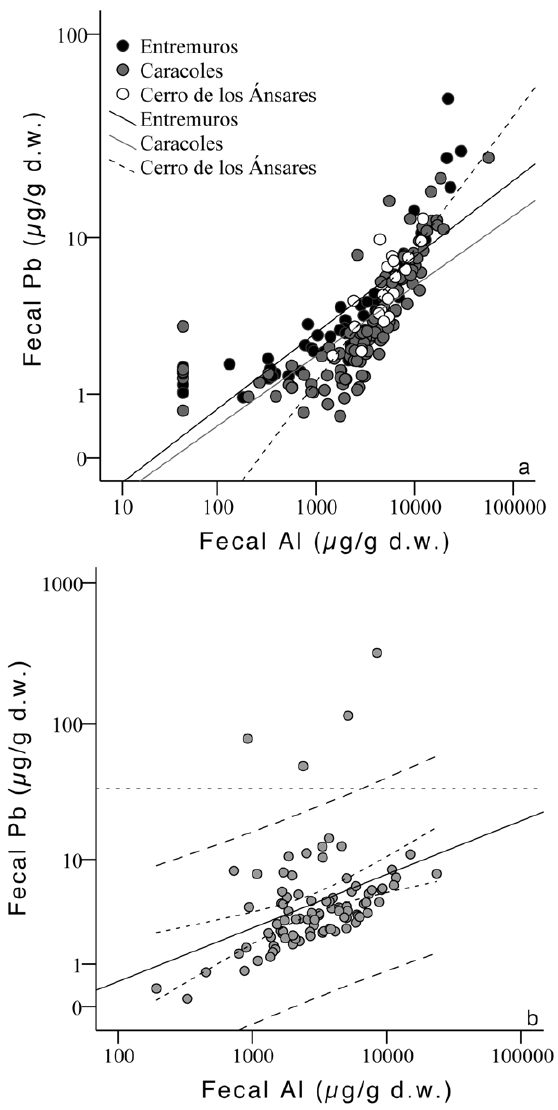
Figure 4. Relationship between Pb and Al concentration ( m g/g dry weight) in (a) feces of greylag geese from three different sampling sites, and (b) feces of purple gallinule collected in Entremuros (black dotted lines represent the 95% confidence and prediction intervals and the horizontal control line shows the 34 m g/g Pb level indicative of exposure to point sources of Pb; [ 32,33 ] ).